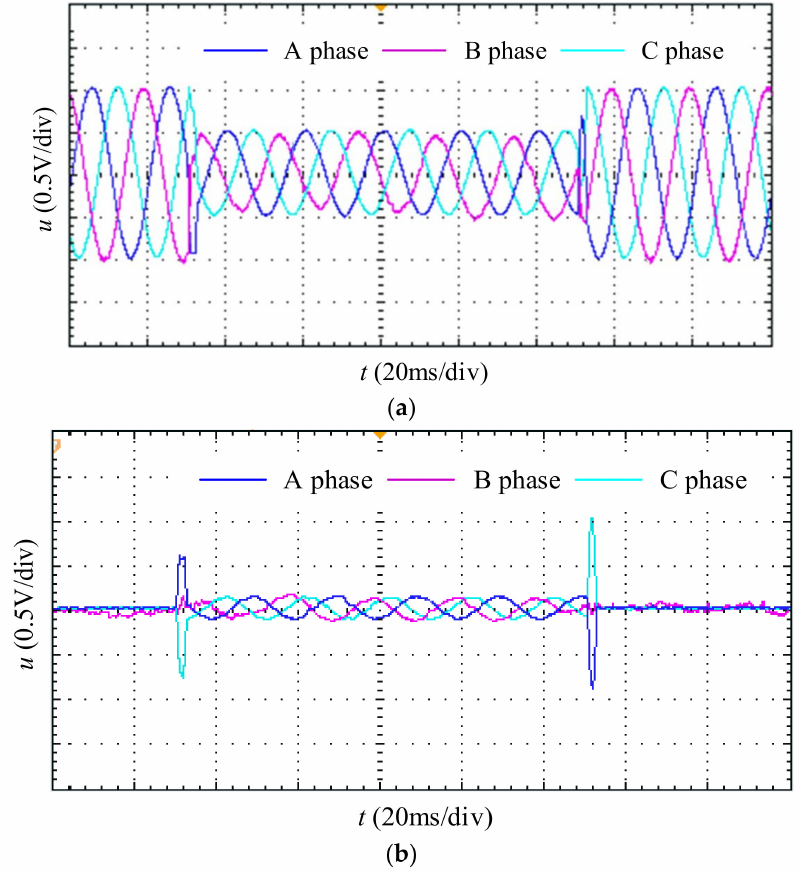
Figure 15. The results of extracting positive-sequence and negative-sequence voltage compo- nent in hardware-in-the-loop test; ( a ) positive-sequence voltage component; ( b ) negative-sequence voltage